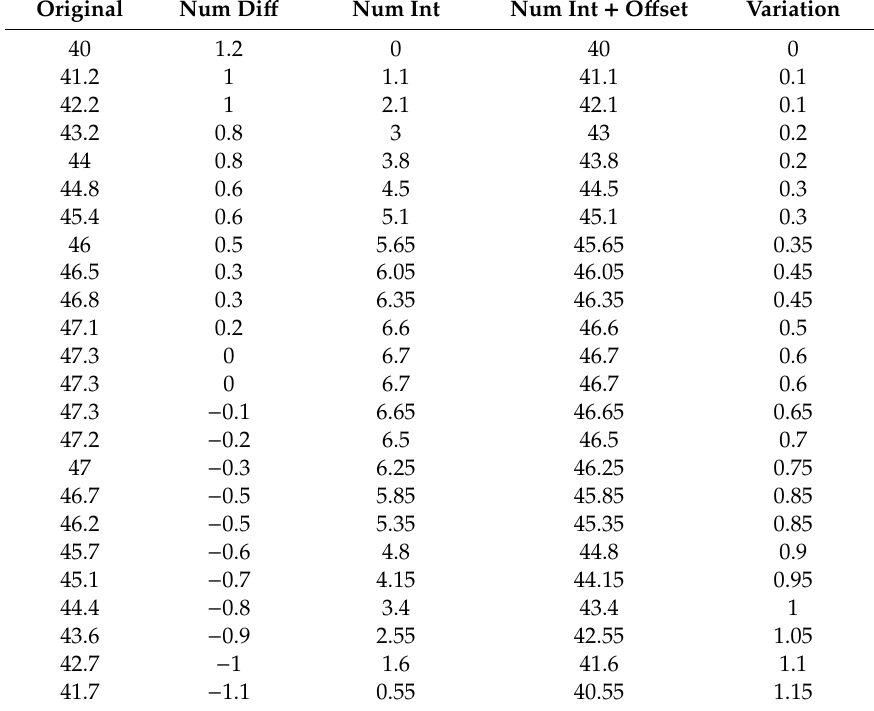
Table 5. E ff ect of numerical methods on signal